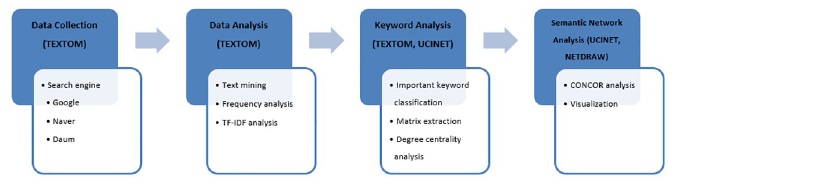
Fig 4. Research methodology block diagram.